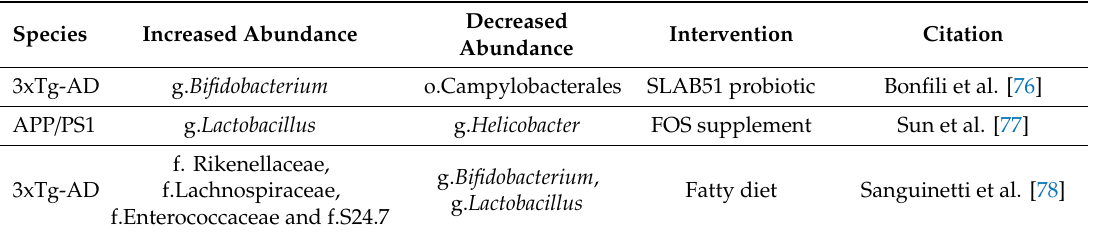
Table 2. Alterations in gut microbiota composition in transgenic mice after the